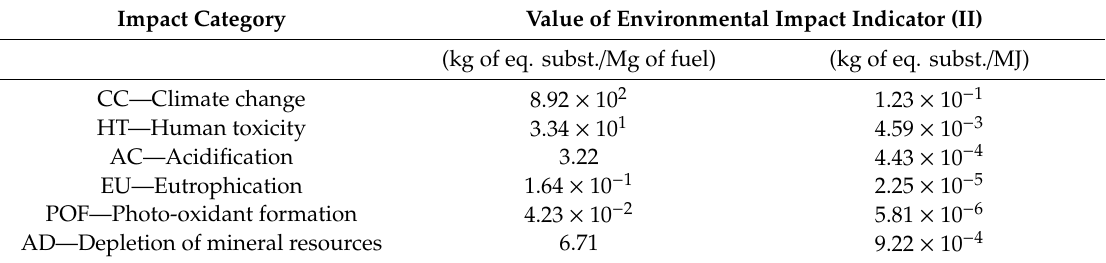
Table 1. Indicators of environmental impact calculated for lignite related to the functional units Mg of fuel and MJ of chemical energy in the